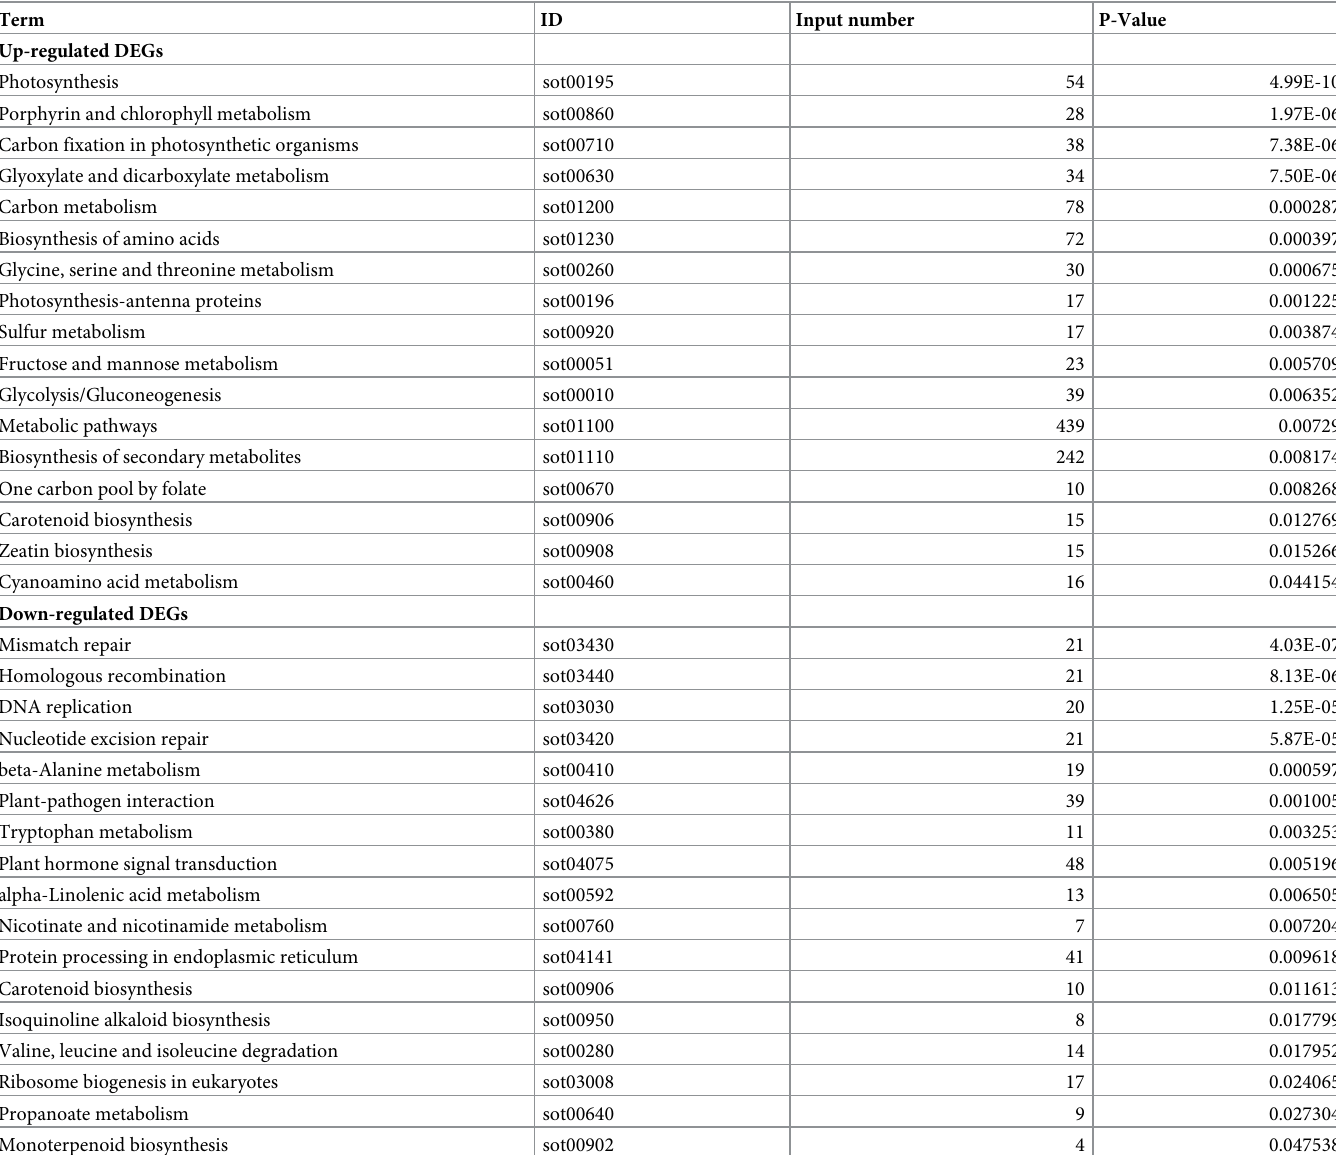
Table 1. The biological processes associated with the differentially expressed genes (DEGs) in the leaf of cultivar X versus cultivar C under N fertilization.